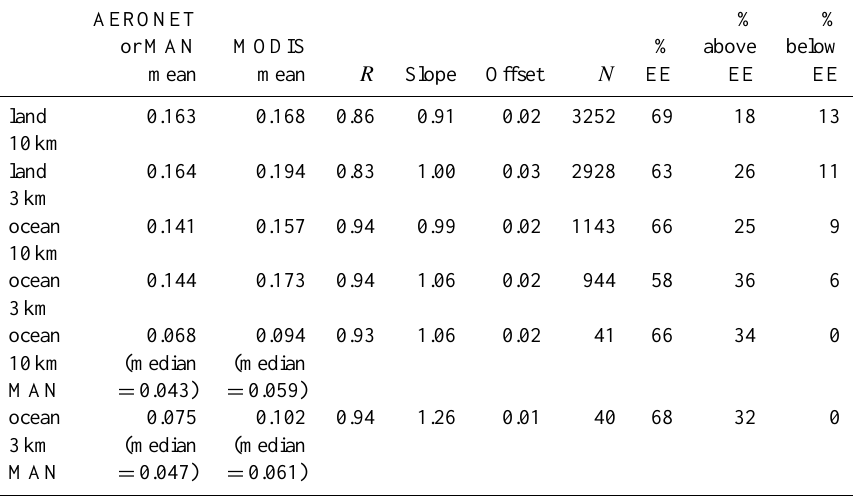
Table 4. Parameters from MODIS-AERONET collocation validation: means of each data set, correlation coefficient, regression slope and offset, number of collocations, percent within expected error ∗ , percent above expected error ∗ and percent below expected error ∗ for 10km and 3km products separated into land and ocean retrievals. The last rows show MODIS-MAN collocations over